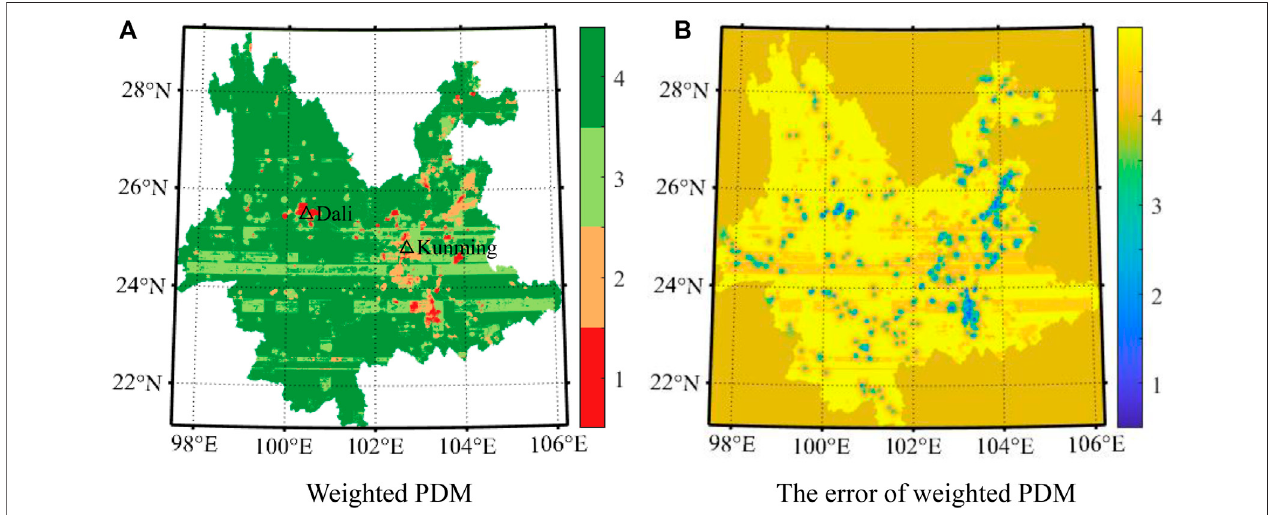
FIGURE 9 | The weighted PDM (A) and corresponding error from the ELM-derived PDM (B) . The numbers (1 – 4) represent the polluted levels.